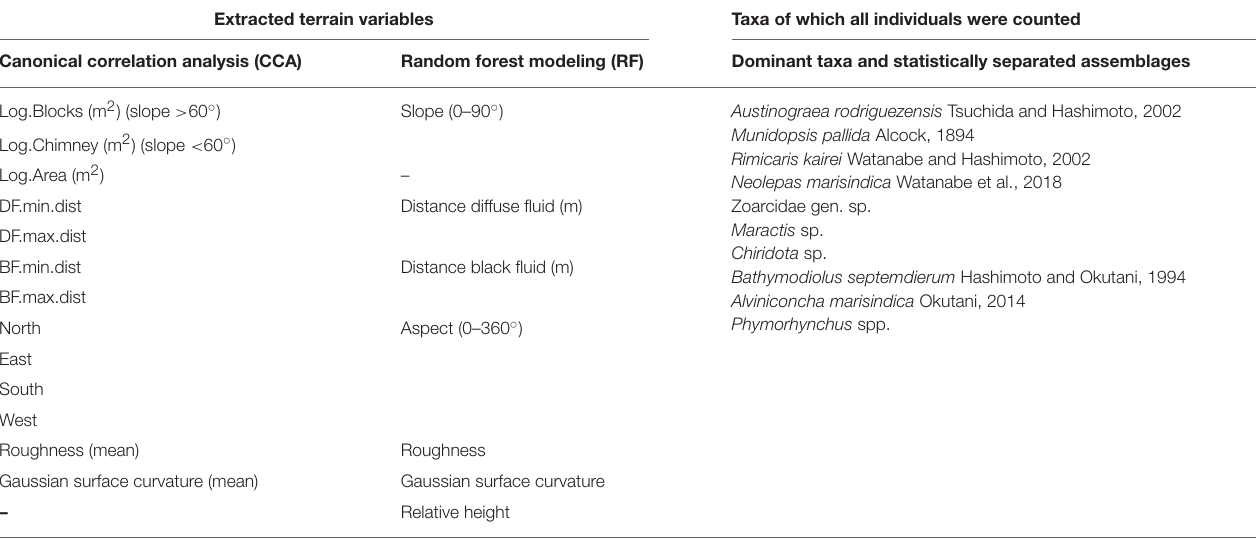
TABLE 1 | Extracted terrain variables used for the Canonical Correlation Analysis (CCA), the Random Forest Modeling (RF) and Taxa of which all individuals were counted for the dominant taxa and statistically separated faunal assemblages. Extracted terrain